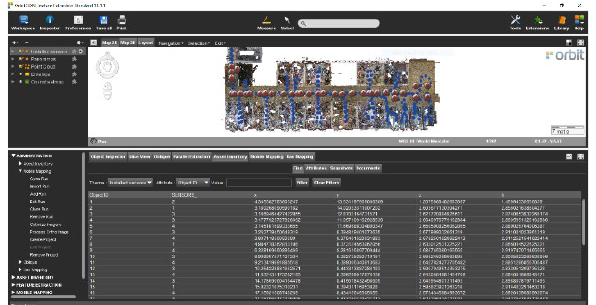
Figure 5: Particular of the Database